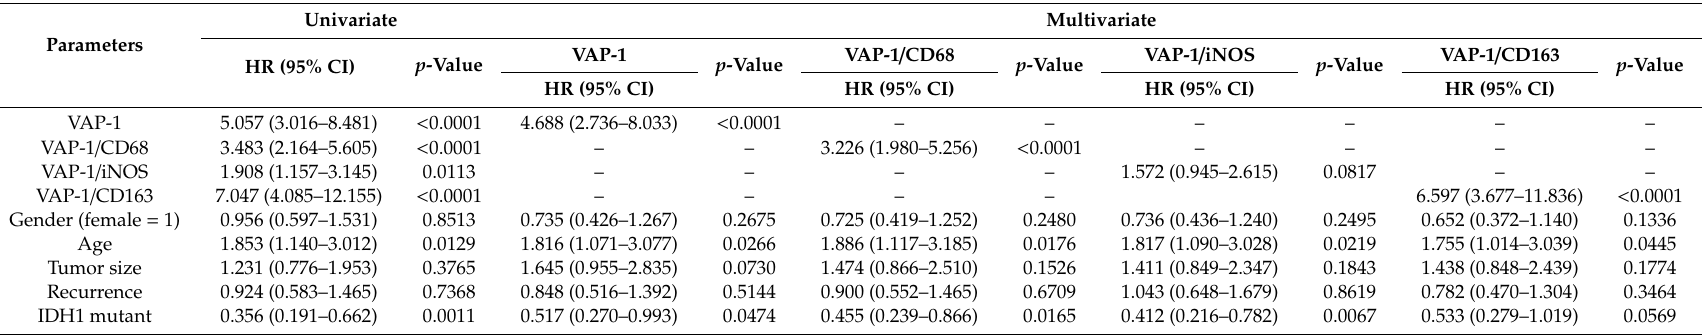
Table 4. Univariate and multivariate Cox proportional hazard models with backwards elimination for predicting tumor progression in glioma patients. Parameters